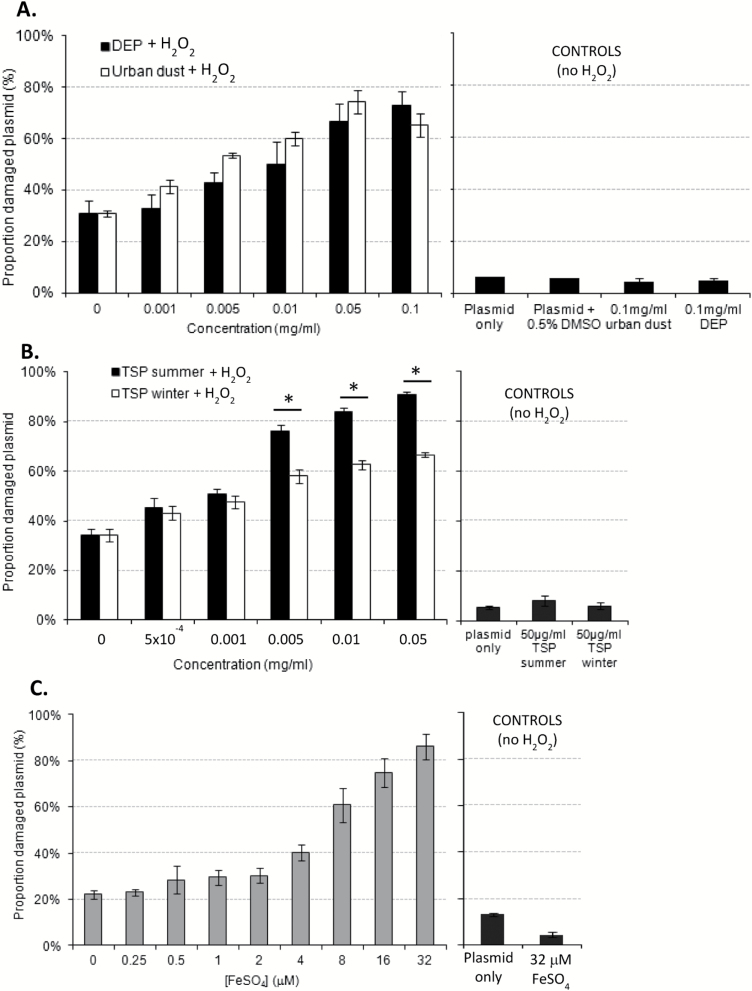
Mean relative plasmid DNA damage induced by urban dust SRM1649a and DEP (A), summer and winter TSP (B), FeSO4 (C) in combination with H2O2. Forty micrograms of pBR322 plasmid was mixed with 0.8mM H2O2 and PM (A and B) or FeSO4 (C) and incubated for 8h at room temperature. H2O2 was not added in controls, which included: plasmid alone, plasmid with the highest concentration of PM, FeSO4 or DMSO. Gel-loading buffer was added to stop the reaction prior to electrophoresis through a 0.6% agarose gel. Ethidium bromide-stained linear, nicked and supercoiled plasmids were visualised with a multimode imager and the intensity of each band was quantified using ImageQuant™. The proportion of damaged plasmid (nicked and linear) in each sample was calculated. Data presented as mean ± SEM (n = 4), *P < 0.05 one-way analysis of variance.